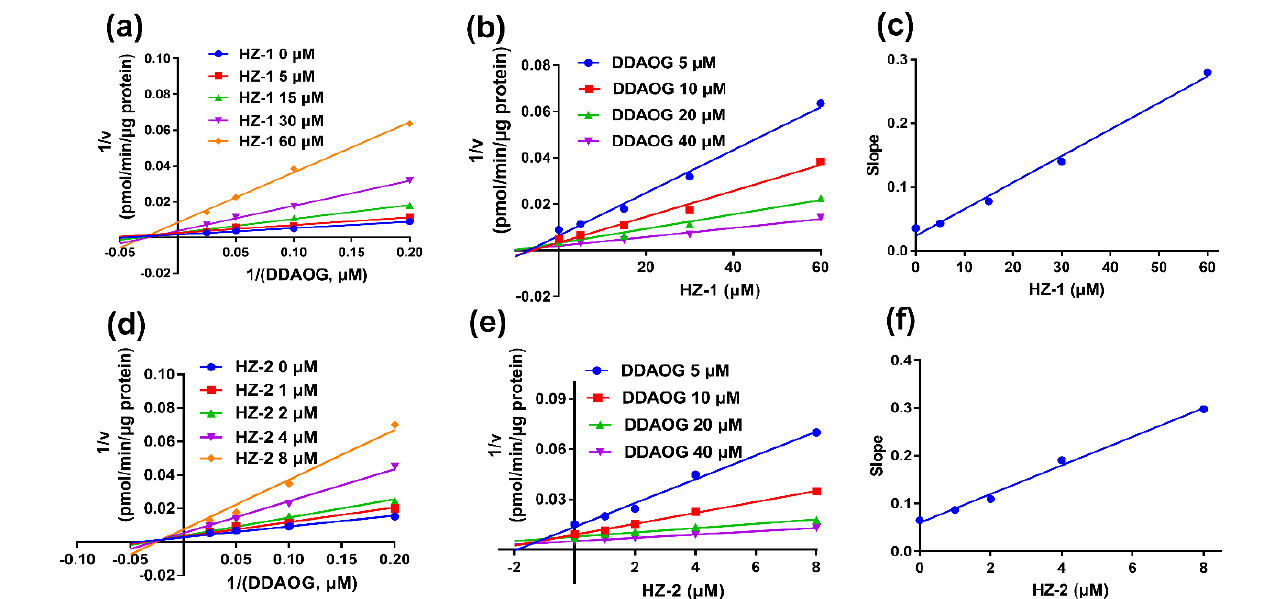
FIGURE 4 - (a) Lineweaver-Burk plot of HZ-1 ’s inhibition towards DDAOG hydrolysis in EcGUS, (b) Dixon plot of HZ-1 ’s inhibition towards DDAOG hydrolysis in EcGUS, (c) Second plot with the slopes from Lineweaver–Burk plot towards the concentrations of HZ-1 , (d) Lineweaver-Burk plot of the inhibition of HZ-2 towards EcGUS-catalyzed DDAOG hydrolysis, (e) Dixon plot of the inhibition of HZ-2 towards EcGUS-catalyzed DDAOG hydrolysis, and (f) Second plot with the slopes from Lineweaver–Burk plot towards the concentrations of HZ-2 . The results shown are the means of duplicate